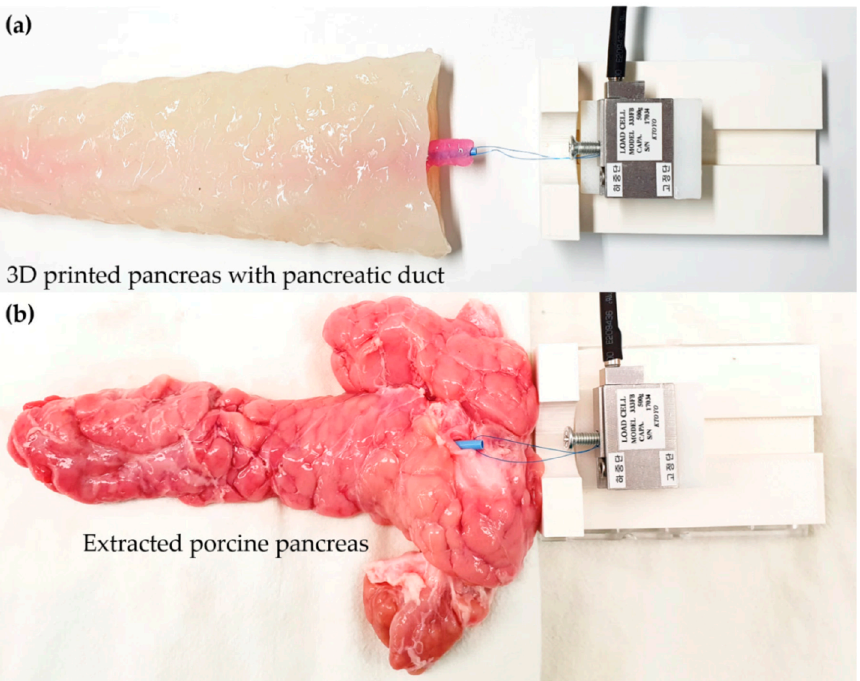
Figure 4. The customized measuring method and the integrated measuring device in ( a ) the 3D- printed pancreatic phantom with the pancreatic duct and ( b ) the extracted porcine